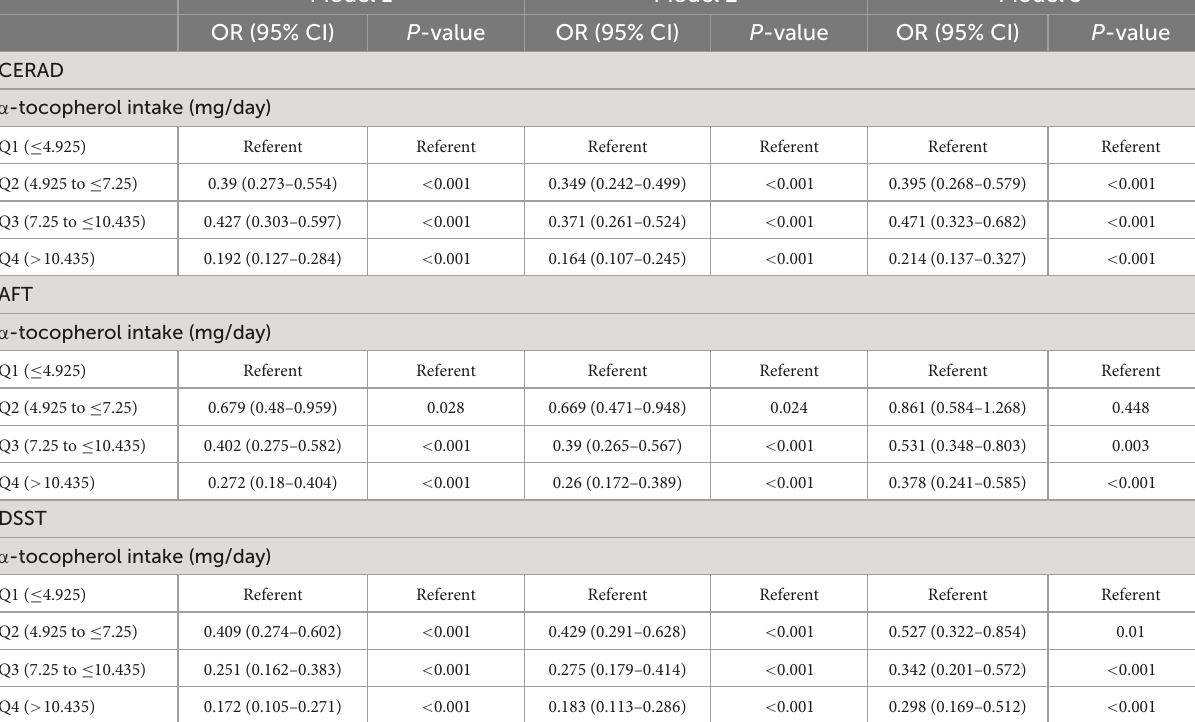
TABLE 5 Associations of mean AL, mean PD, and periodontitis with low cognitive performance.